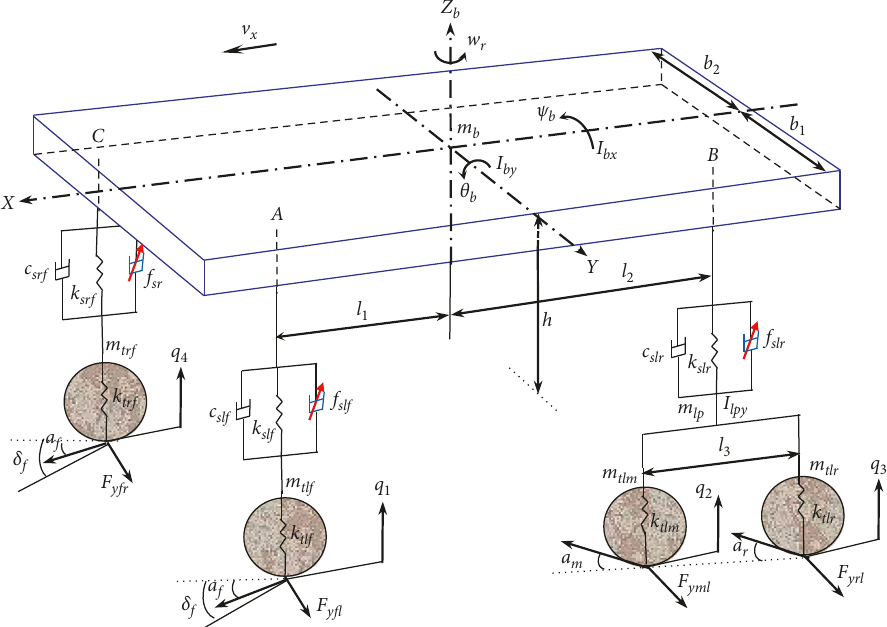
Figure 2: Vertical/lateral coupling dynamics model of heavy-duty vehicle with semiactive suspension.